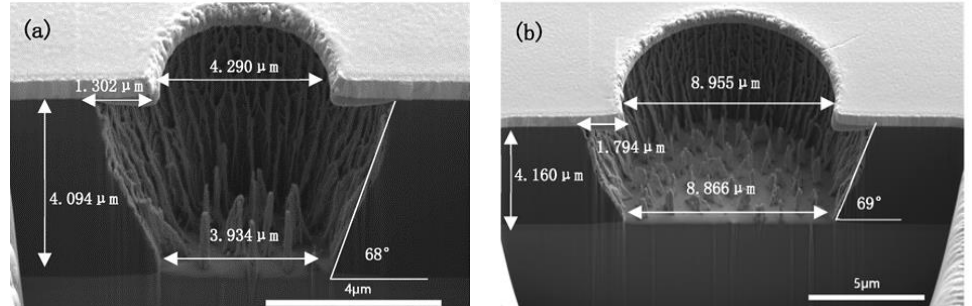
Figure 11. ICP etching of fully cured PI under 2000 W ICP power, 600 W RF power, 10% CHF 3 ratio,